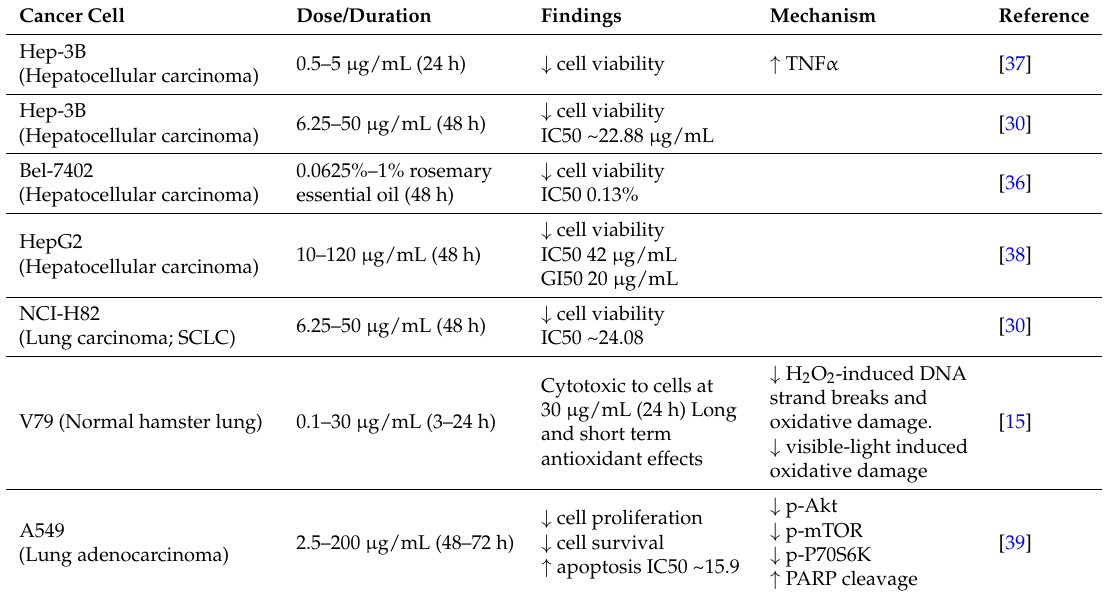
Table 4. Anticancer effects of Rosemary Extract (RE). In vitro studies: liver and lung cancer. Cancer Cell Dose/Duration Findings Mechanism